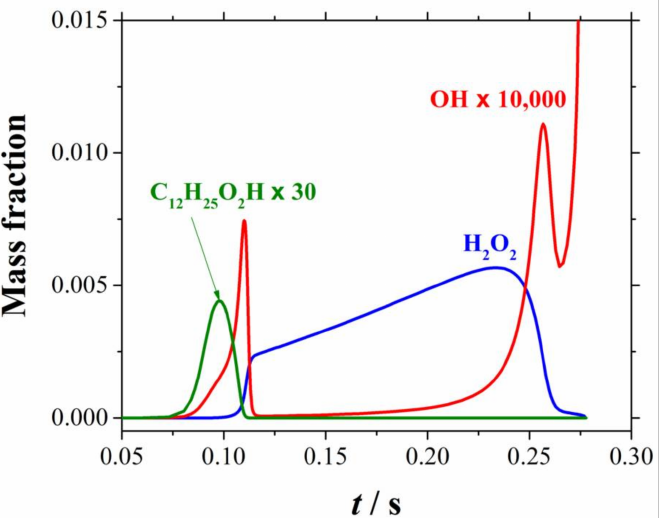
Figure 7. Time histories of peroxides C 12 H 25 O 2 H and H 2 O 2 as well as hydroxyl OH during self- ignition of the homogeneous stoichiometric n-dodecane–air mixture at the initial temperature T g 0 = 650 K and pressure P = 1 bar (no